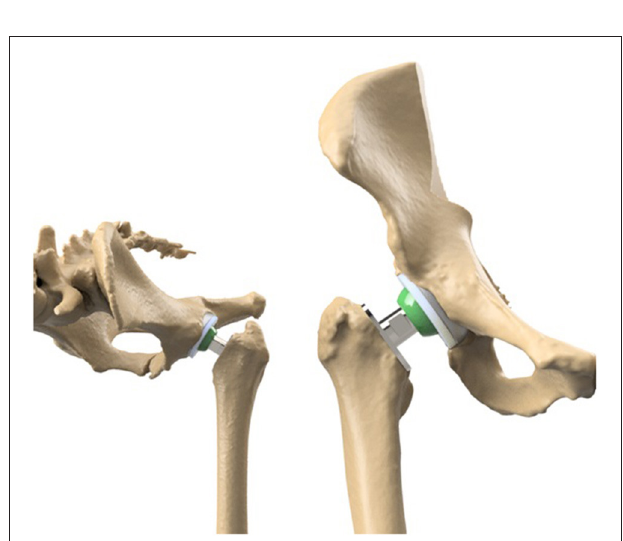
FIGURE 6 | The comparable set-up of the total hip arthroplasty in humans and dogs. On the left the set-up in dogs and on the right the set-up in